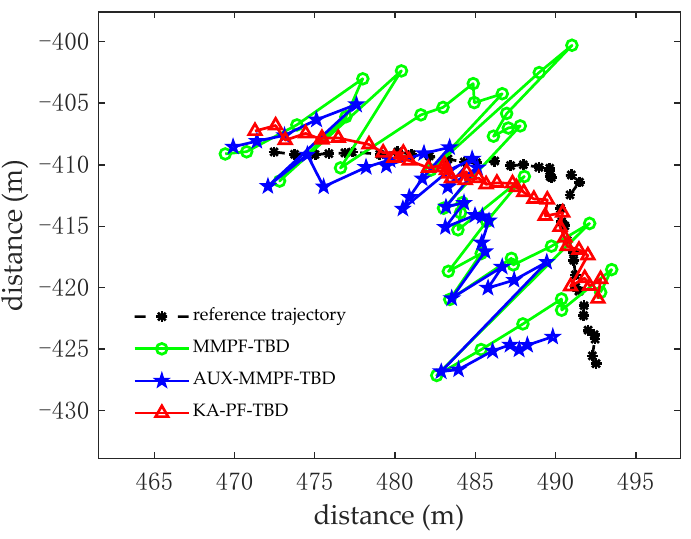
Figure 10. Statistical characteristics of reverberation and target echo data.